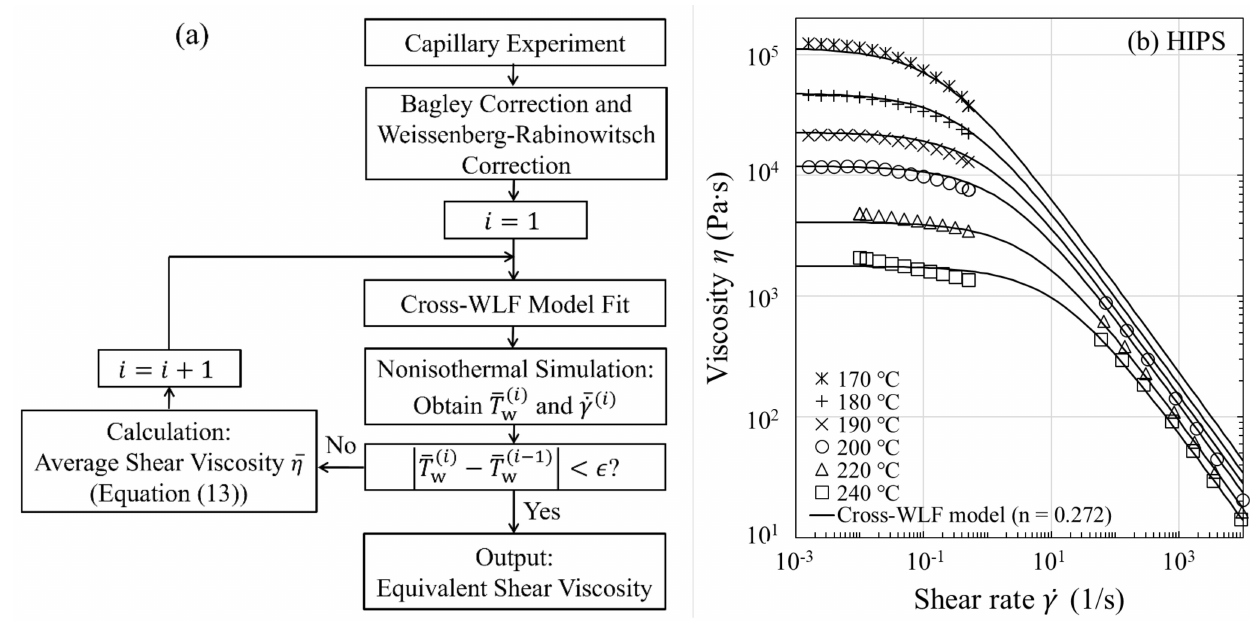
. γ ). ( b ) Uncorrected steady-state